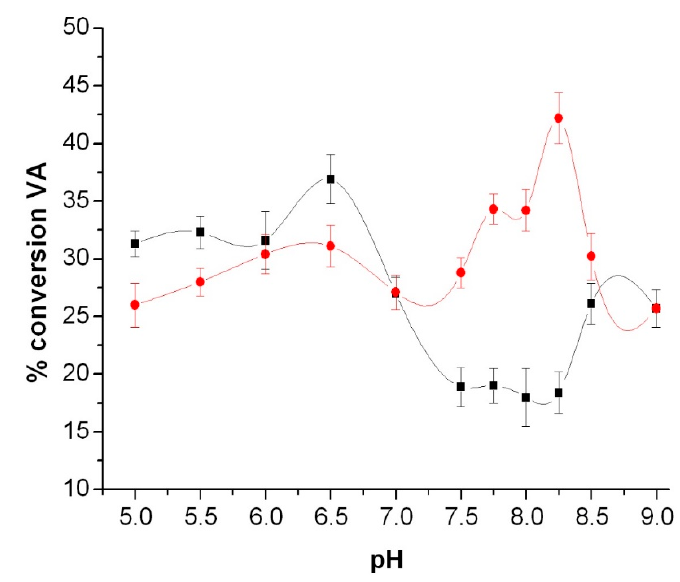
Figure 6. pH-dependence of conversion ratio of VA to VAH catalysed by 1 ( ● ), and without catalyst ( ■ ) (at 40 °C).